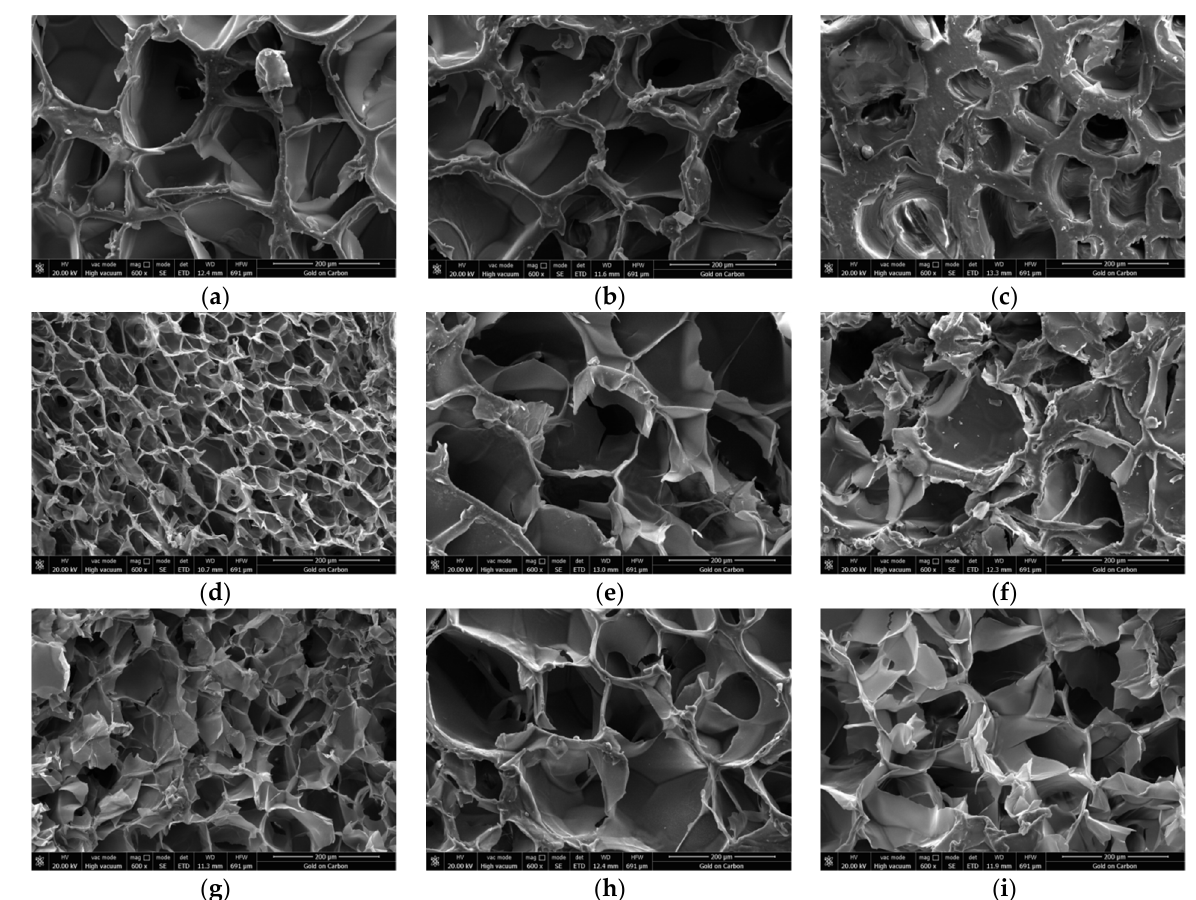
Figure 2. Scanning electron microscopy (SEM) micrographs of the alginate/gelatin/agarose hydrogels. ( a ) A magnified image of hydrogel composed of 10% gelatin, 2% sodium alginate and 0.2% agarose. ( b ) A magnified image of hydrogel composed of 15% gelatin, 2% sodium alginate and 0.2% agarose. ( c ) A magnified image of hydrogel composed of 20% gelatin, 2% sodium alginate and 0.2% agarose. ( d ) A magnified image of hydrogel composed of 5% gelatin, 0% sodium alginate and 0.2% agarose. ( e ) A magnified image of hydrogel composed of 5% gelatin, 4% sodium alginate and 0.2% agarose. ( f ) A magnified image of hydrogel composed of 5% gelatin, 8% sodium alginate and 0.2% agarose. ( g ) A magnified image of hydrogel composed of 5% gelatin, 2% sodium alginate and 0% agarose. ( h ) A magnified image of hydrogel composed of 5% gelatin, 2% sodium alginate and 0.4% agarose. ( i ) A magnified image of hydrogel composed of 5% gelatin, 2% sodium alginate and 0.8% agarose.